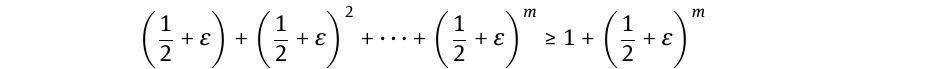
Fig. 4. Graph W 2 . The longest edge has weight 1 , the shortest edges have weights (cid:0) 1 2 + ε (cid:1) have weights (cid:0) 1 2 + ε (cid:1)